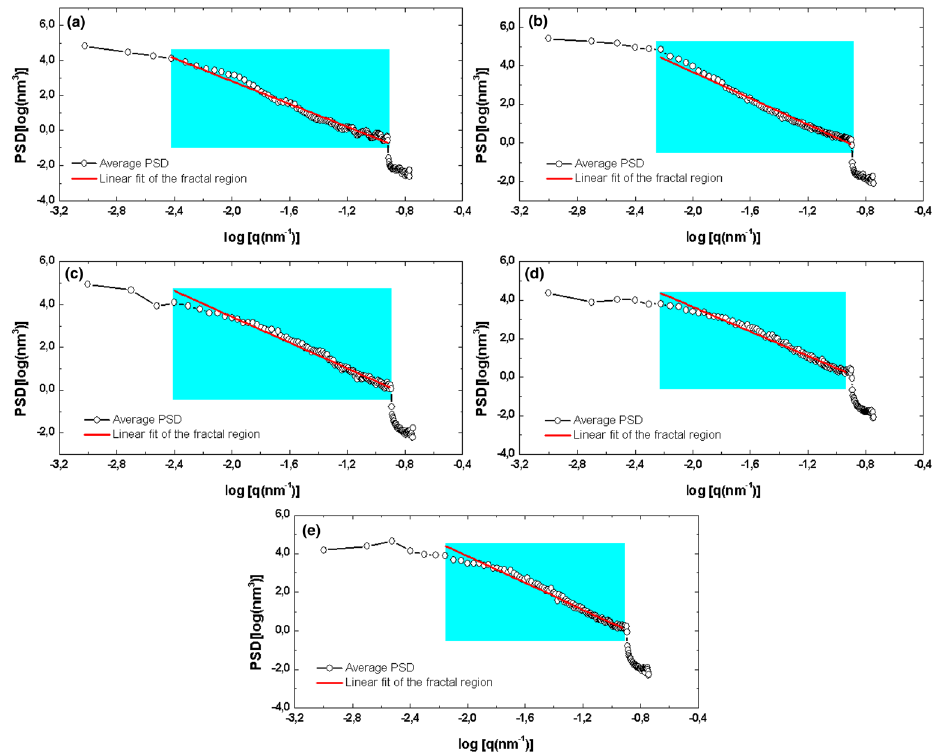
Figure 5. Average PSD and linear fit of the fractal region of the PSD spectra of ( a ) #1, ( b ) #2, ( c ) #3, ( d ) #4, and ( e ) #5.